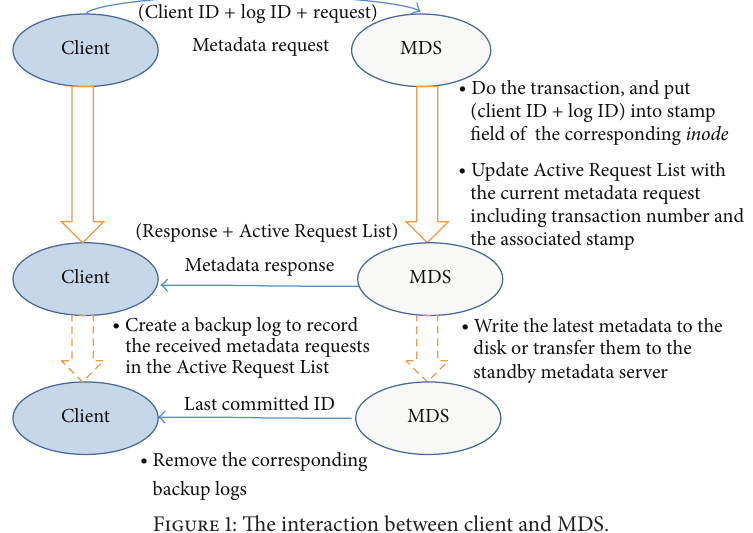
Figure 1: The interaction between client and